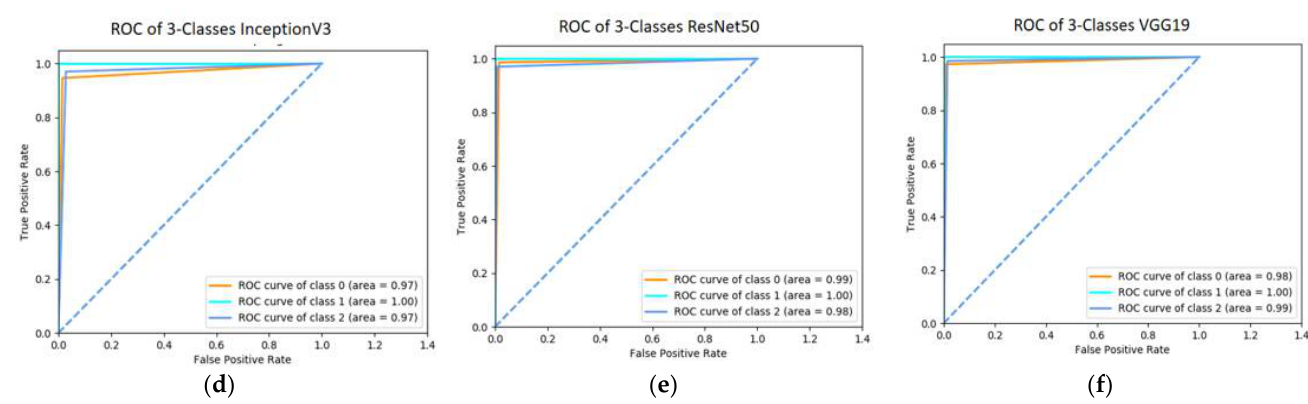
Figure 9. ROC AUC for two and three classes: ( a ) AUC two-class classifier InceptionV3 model; ( b ) AUC two-class classifier ResNet50 model; ( c ) AUC of two-class classifier VGG19 model; ( d ) AUC of three-class classifier InceptionV3 model; ( e ) AUC of three classifier ResNet50 model; ( f ) AUC of three-class classifier VGG19 model.